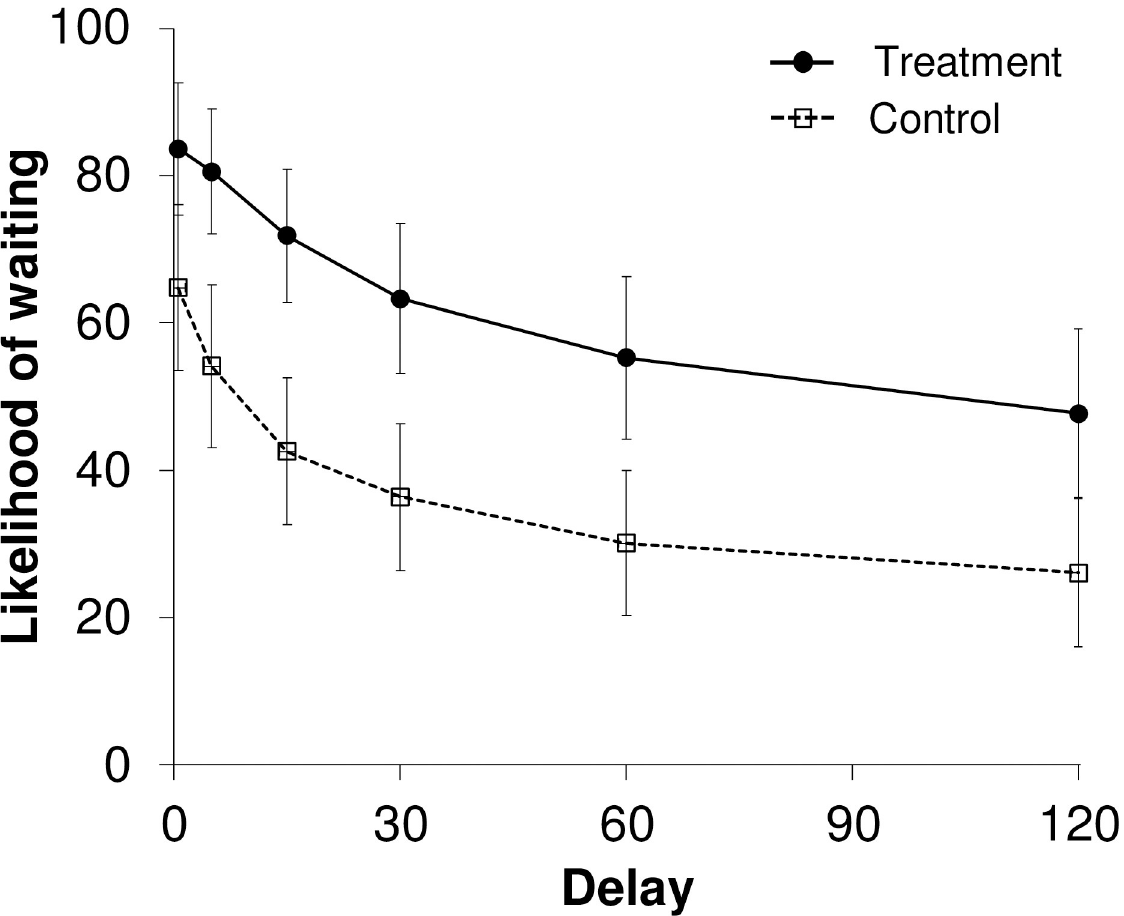
Fig 1. Mean likelihood of waiting to reply to a text message as a function of delay to the destination for the treatment and control groups. Error bars represent 95% confidence intervals.